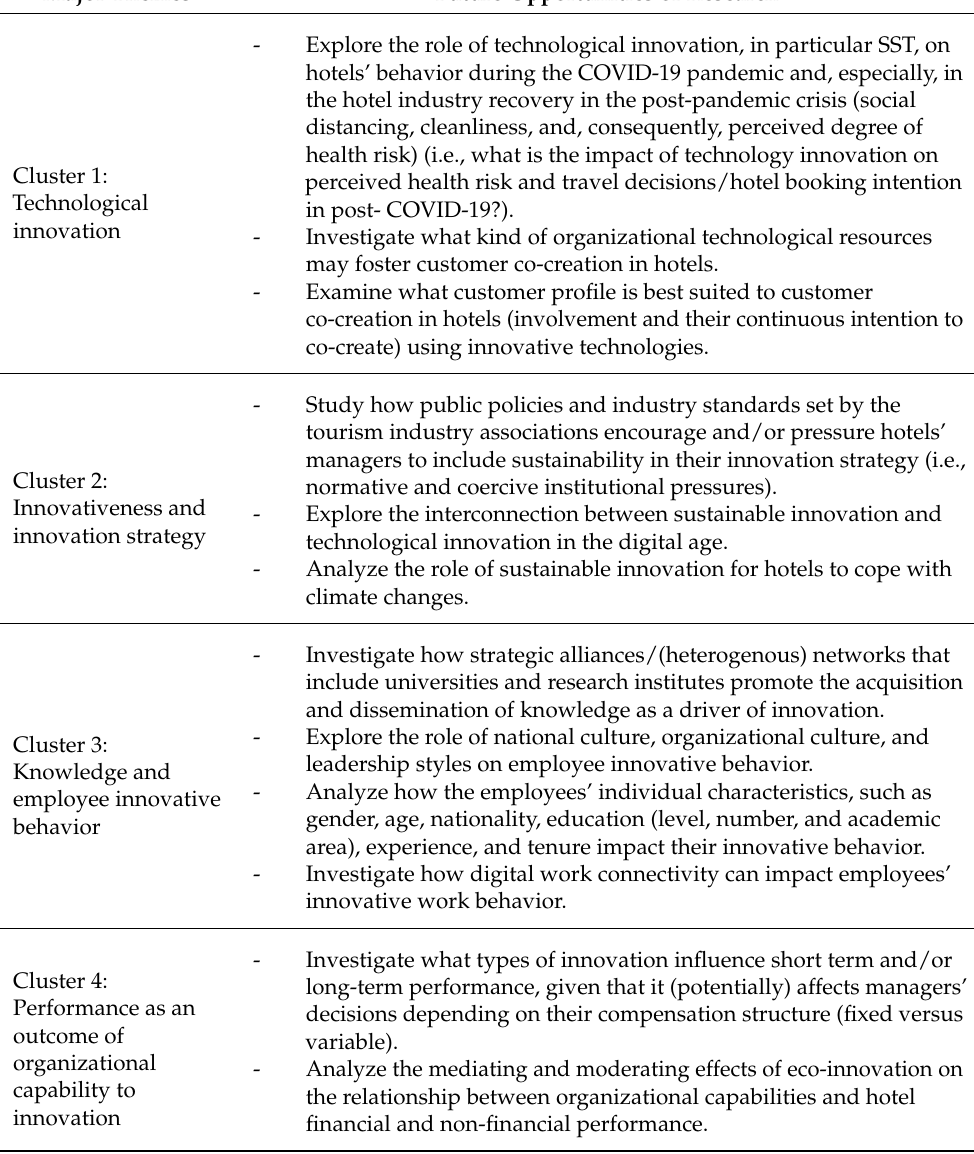
Table 2. Opportunities for research on innovation in